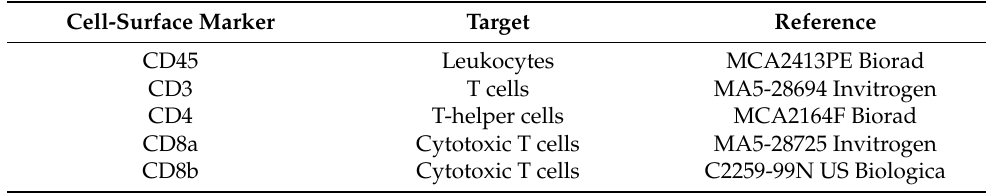
Table 3. Target phenotypes used in analysis of intestinal T